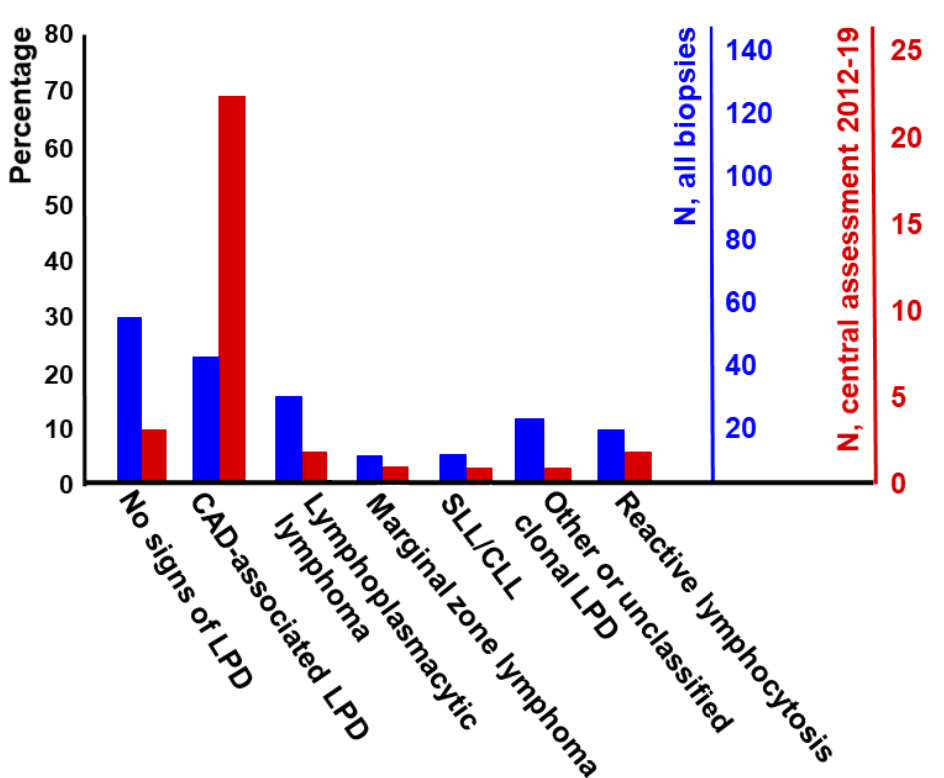
Figure 2. Bone marrow biopsy findings in 176 CAD patients with available histology data; comparison by percentage. Centralized revision increased the detection rate of clonal LPD and the percentage of biopsies interpreted as CAD-associated LPD. Blue bars, all biopsies. Red bars, biopsies that underwent a centralized review from 2012 through 2019. CLL, chronic lymphocytic leukemia; LPD, lymphoproliferative disorder; SLL, small lymphocytic B-cell lymphoma. Figure first published in Blood 2020 [26], reused under general permission. © the American Society of Hematology.